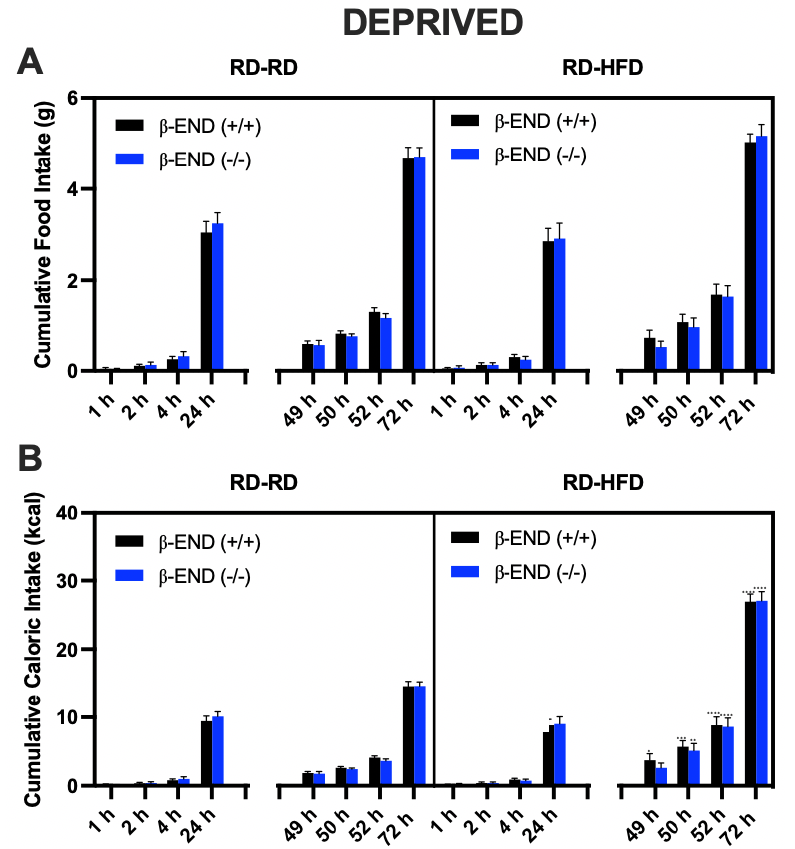
Figure 2. Cumulative Food consumption ( A ) and caloric intake ( B ) in deprived beta-endorphin knockout mice and their wildtype littermates/controls ( n = 9/group). Animals were randomly as- signed to receive HFD or RD following a 24 h deprivation period. Food and caloric intake were measured on day 1 (baseline: at 1, 2, 4, and 24 h) and day 3 (after deprivation: at 49, 50, 52, and 72 h). A three-way ANOVA revealed an interaction between time and food assignment in caloric in- take. All data are expressed as mean ± SEM. No significant differences were found between mice of the two